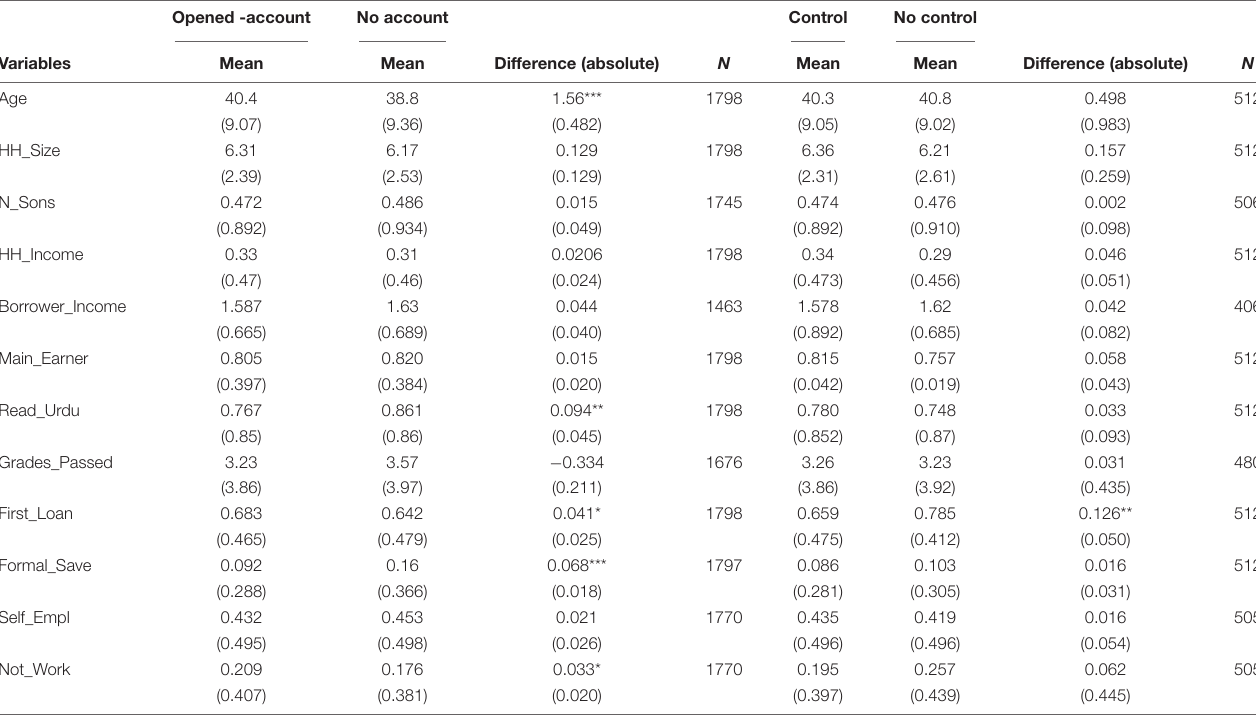
TABLE 2 | Summary statistics by Asaan savings account and level of